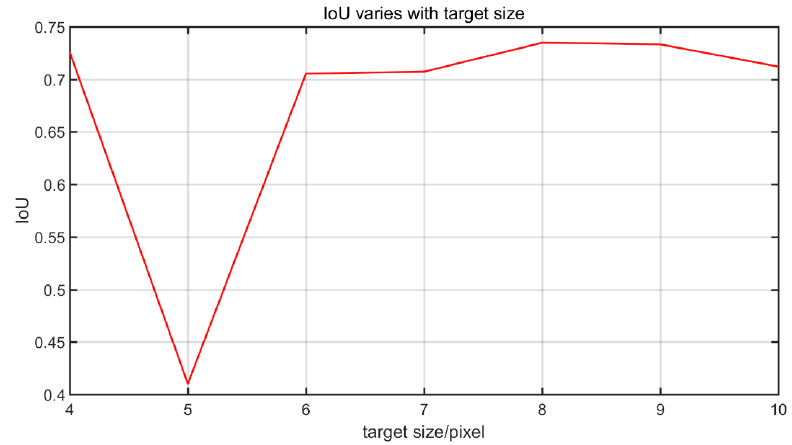
Figure 10. Curve of target pixel size versus the